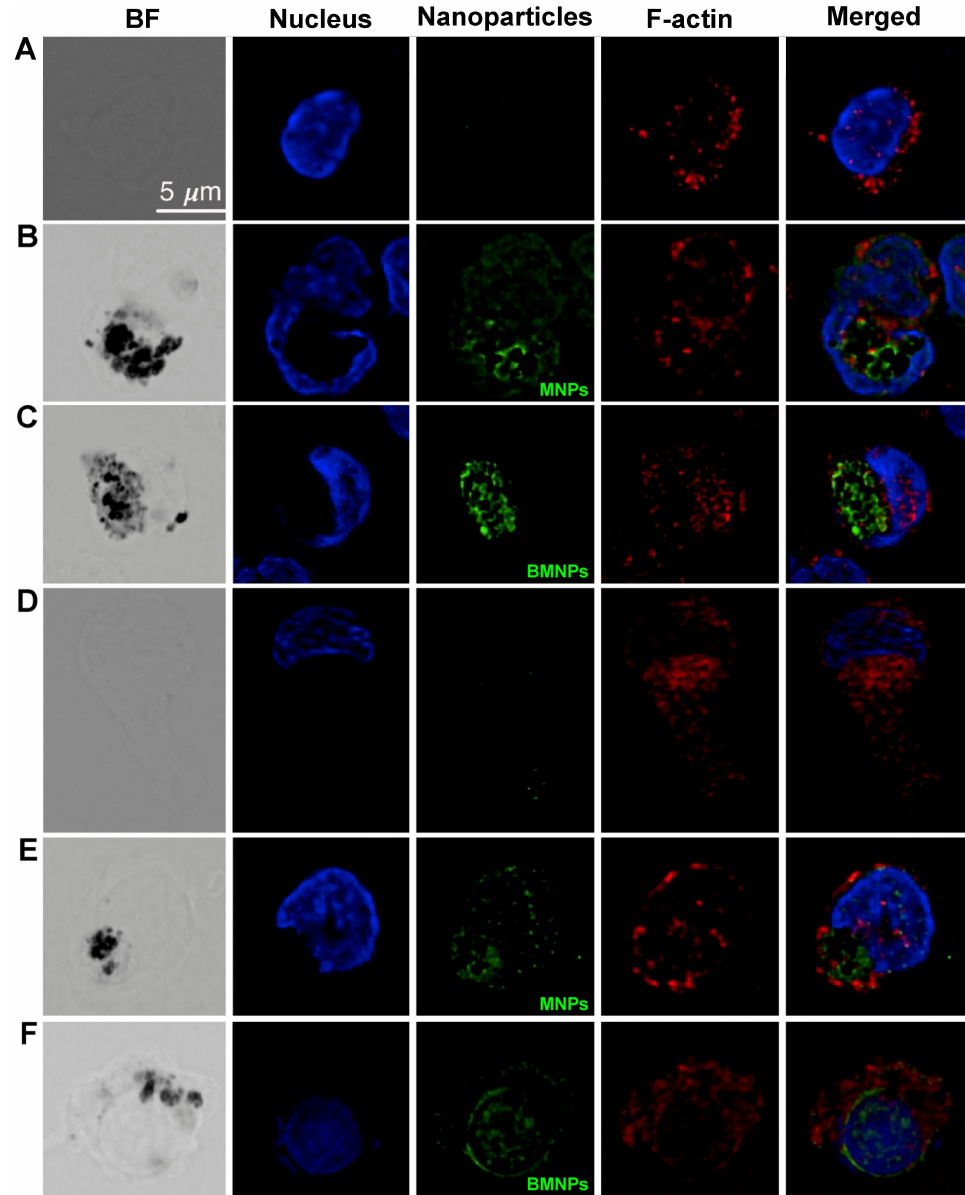
Figure 5. Internalization of MNPs and BMNPs by human monocytes and iDCs. Monocytes (panels ( A – C )) and iDCs (panels ( D – F )) were treated with 50 µ g/mL GFP-conjugated MNPs (panels ( B , E )) or BMNPs (panels ( C , F )) for 2 h and the particle cellular uptake was visualized by wide-field deconvolution fluorescence microscopy. Untreated cells are illustrated in panels ( A ) and ( D ). Shown are six representative fields (top to bottom rows). From left to right, bright field (BF), DAPI (Nucleus), GFP (Nanoparticles), and SiR-actin (F-actin) individual channels are shown. On the far-right, merged channels are shown. Scale bar is 5 µ